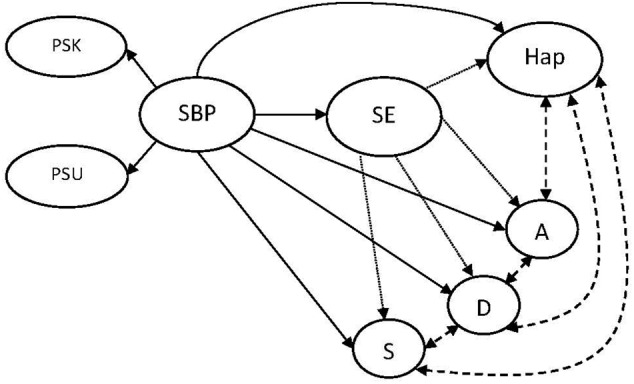
The proposed structural equation model. Solid lines denote regression weights and dashed lines denote correlations. PSK, strength-based parenting knowledge component; PSU, strength-based parenting use component; SBP, strength-based parenting; SE, self-efficacy; Hap, happiness; A, anxiety; D, depression; S, stress.